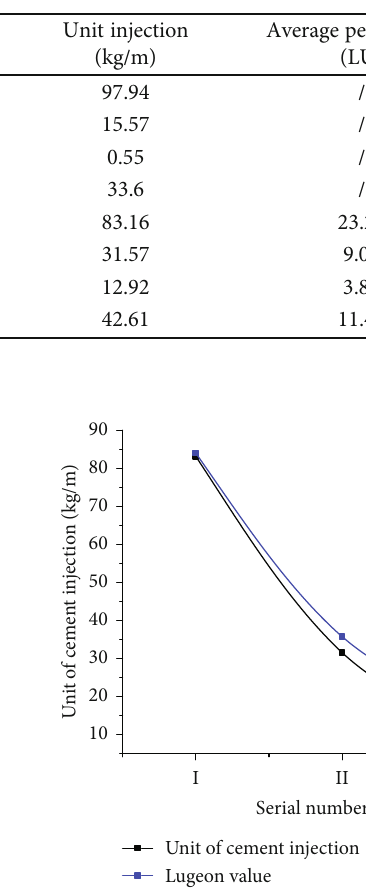
Figure 8: Schematic diagram of the grouting hole layout. Table 7: Consolidation grouting results of the #25 dam section.